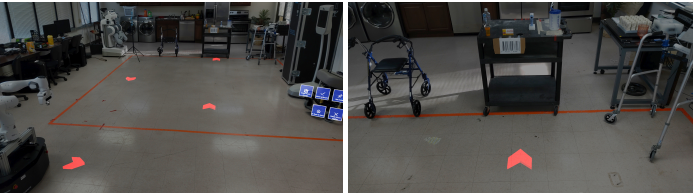
Figure 8. ( Left ) A view of the three ASAs that the robot will visit. A fourth ASA was added to the left of the cart to make the return safer. ( Right ) A view of the cart with graspable objects, the barcode, and the ASA near the cart.